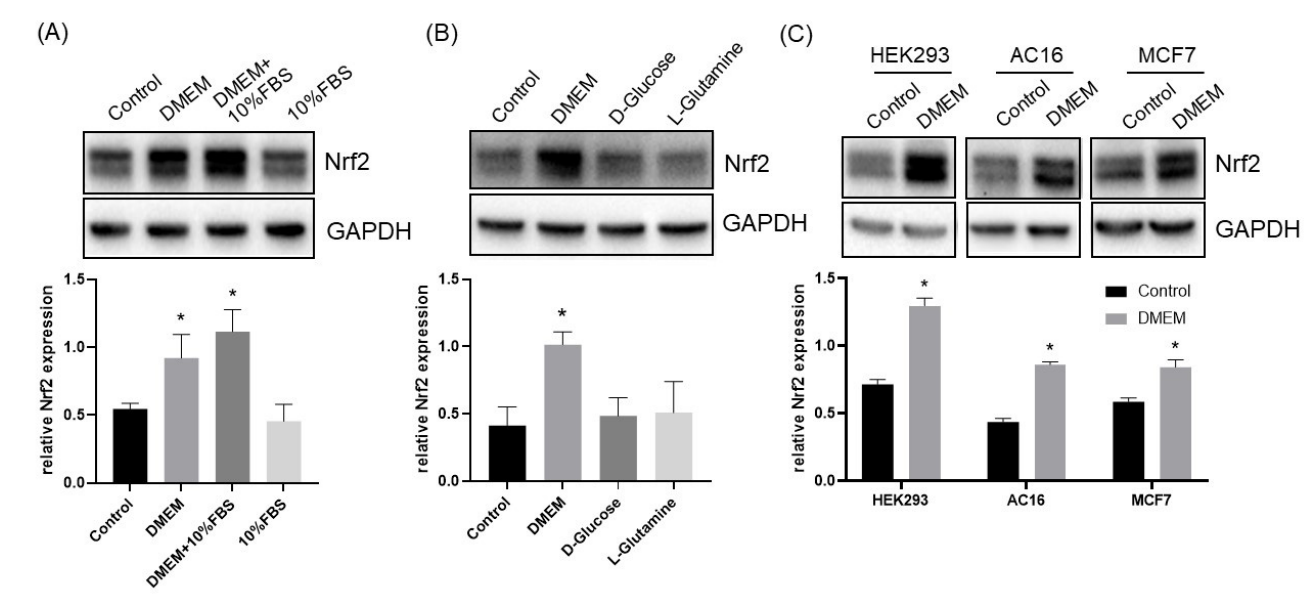
Figure 1. Fresh DMEM Induces Nrf2 Protein. HeLa cells at day 3 after subculture in DMEM with 10% FBS were either left untreated (control) or had a culture medium change to fresh DMEM or fresh DMEM with 10% FBS ( A ). Without changing the medium, cells were treated with 10% FBS ( A ), 25 mM glucose or 4 mM glutamine ( B ). Alternatively, HEK293, AC16 or MCF7 cells were left untreated (control) or had a culture medium change to fresh DMEM ( C ). The cells were collected at 4 h after harvesting for measuring Nrf2 protein levels by Western Blot, using GAPDH as a loading control. The intensities of the Nrf2 or GAPDH band were quantified by NIH ImageJ and presented as means ± SD of Nrf2/GAPDH ratio from three independent experiments. * indicates adjusted p value < 0.05 compared to the control by one-way ANOVA, corrected by Dunnett’s multiple comparisons test ( A , B ) or p < 0.05 compared to the control by student’s t test ( C ).